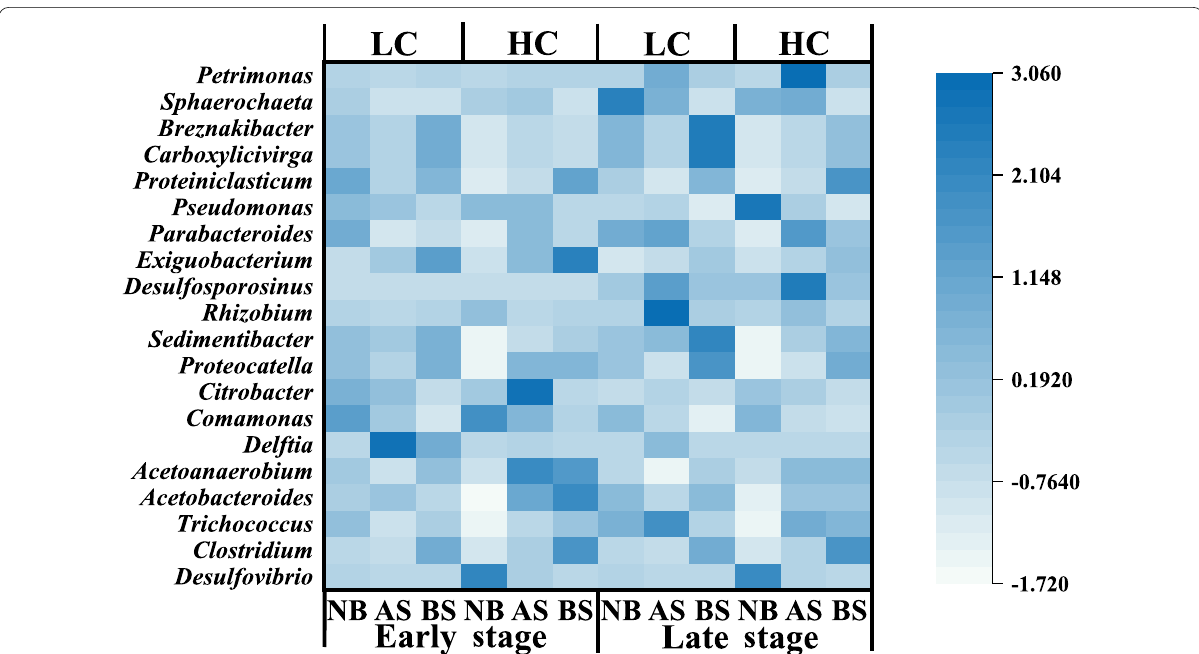
Fig. 3 Heatmap of the top 20 abundant genera (excluding the genus undefined at the genus level). Darker and lighter blue indicate the relative abundance of each OTU in different samples depending on Z-score (Z Low concentration; HC: High concentration; NB: Microbial samples in “No BC” systems; AS: Microorganism suspended in the aqueous solution;